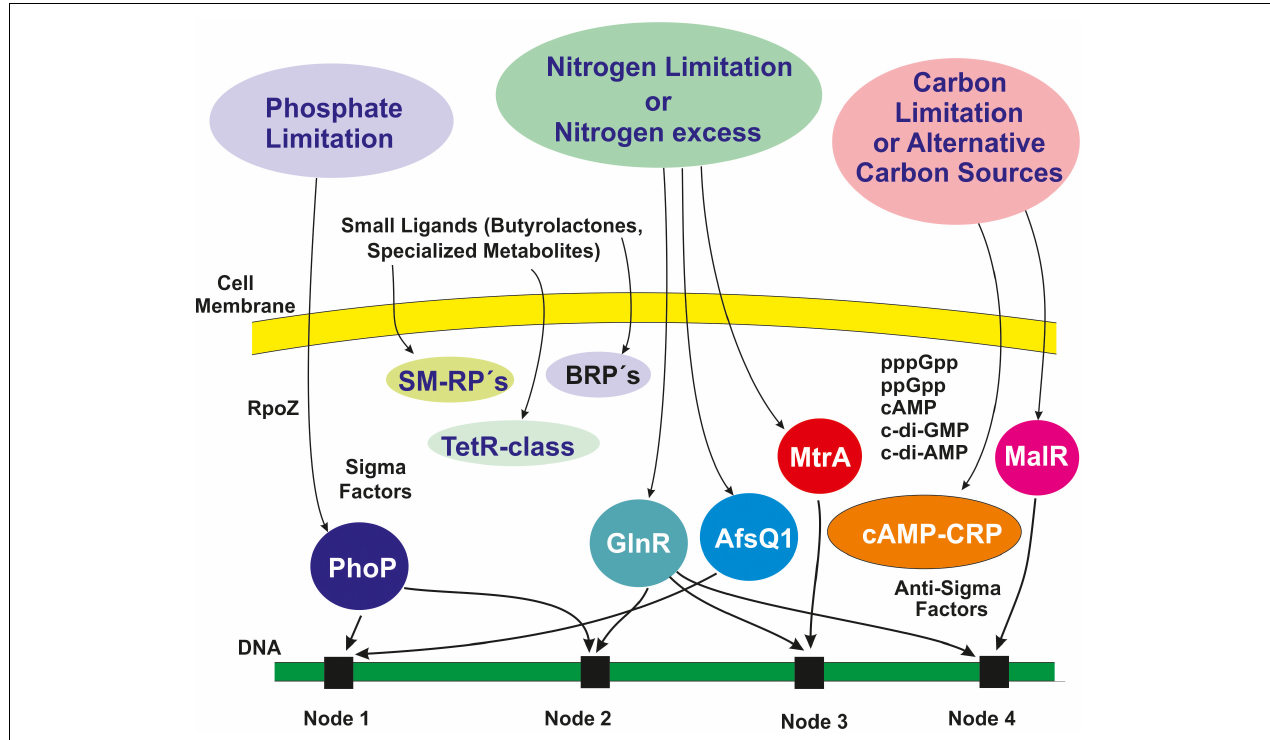
FIGURE 4 | Schematic representation of overlapping layers of regulation that reinforce the safety net. The outer circles represent nutritional stresses that elicit regulatory responses (detailed in Figures 1–3 ). Additional regulatory elements including sigma factors, highly phosphorylated and cyclic nucleotides are shown inside the cell. Receptors proteins (SM-RPs, BRPs) and the TetR-class transcriptional regulators are receptors of signal molecules that are secreted and re-enter the cell. Four integration nodes are highlighted in black boxes in the DNA. The different regulatory sigma and anti-sigma factors and the ligand receptor proteins are connected to distinct nodes (not shown; see text). BRPs, γ -butyrolactone receptor proteins; SM-RPs, specialized metabolites receptor proteins; CRP, cAMP receptor